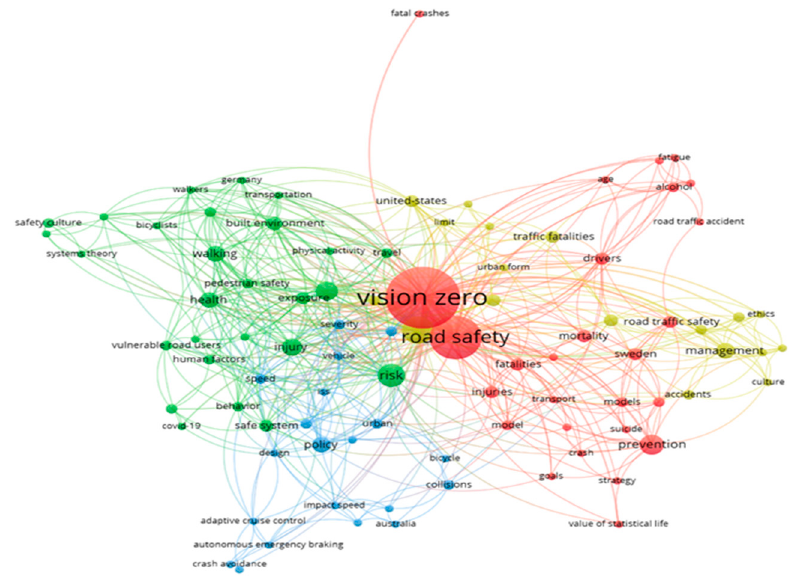
Figure 2. Keywords co-occurrence network of Vision Zero.